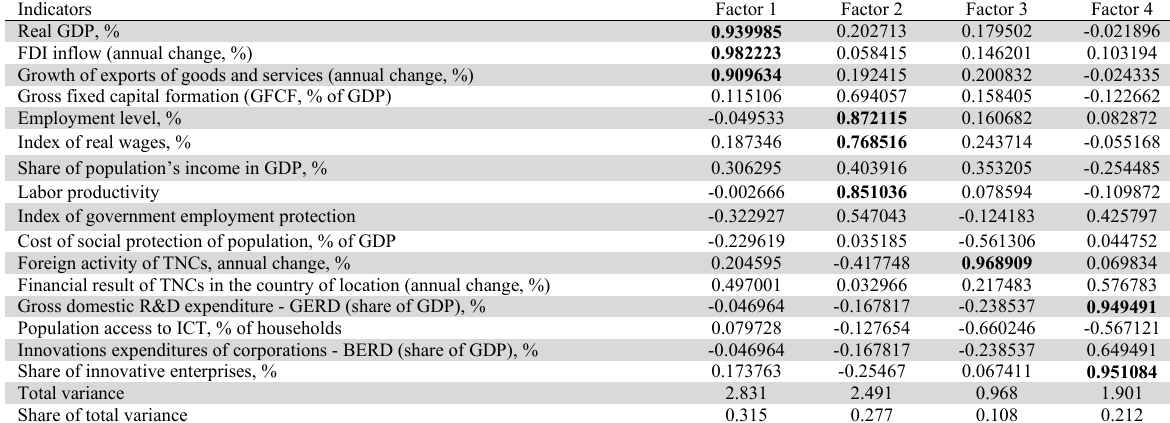
Results of factor analysis using the principal components analysis (developed by the author based on OESD